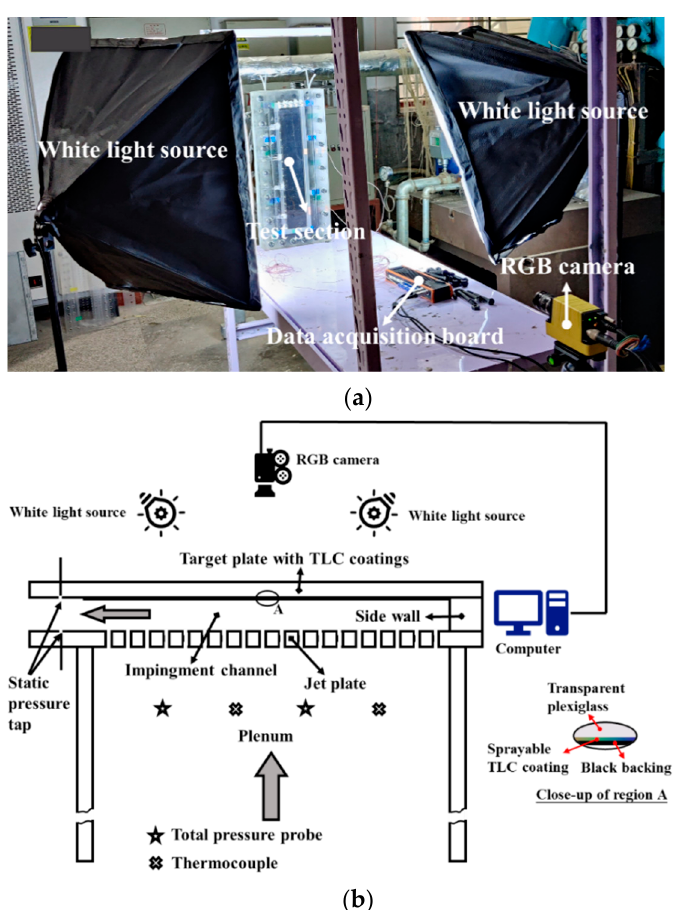
Figure 3. Measurement method and techniques for the jet impingement flow and heat transfer: ( a ) photograph of the measurement equipment; ( b ) illustration of the measurement method.